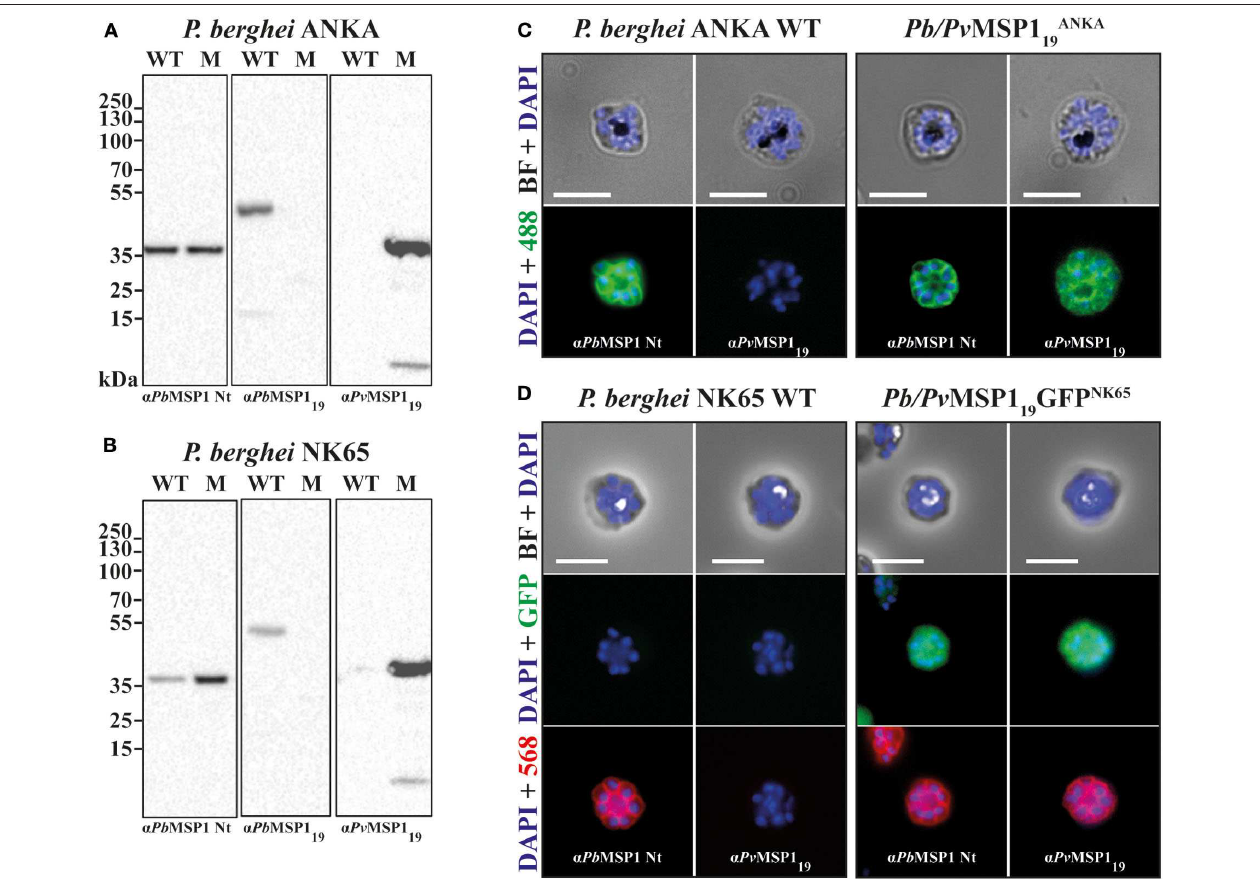
FIGURE 2 | The P. vivax MSP1 19 is correctly expressed in the hybrid Pb/Pv lines. Western blot analysis on RIPA extracts of P. berghei ANKA (A) and NK65 (B) wild type (WT) and mutant (M) lines schizonts using monoclonal antibodies to the N-terminal ( α PbMSP1 Nt) and C-terminal ( α Pb MSP1 19 ) regions of the P. berghei MSP1, and to the 19-kDa C-terminal region of P. vivax α Pv MSP1 19 . Immunofluorescence on fixed and permeabilized schizonts of P. berghei ANKA WT and Pb/Pv MSP1 ANKA 19 (C) , and of P. berghei NK65 WT and Pb/Pv MSP1 19 GFP NK65 (D) using monoclonal antibodies to the N-terminal ( α PbMSP1 Nt) regions of the P. berghei MSP1, and to the 19-kDa C-terminal region of P. vivax α Pv MSP1 19 . Secondary antibodies are Alexa Fluor-488 or − 568. Cells were mounted between lamina and diluted in PBS containing DAPI. Scale bars: 5 µ